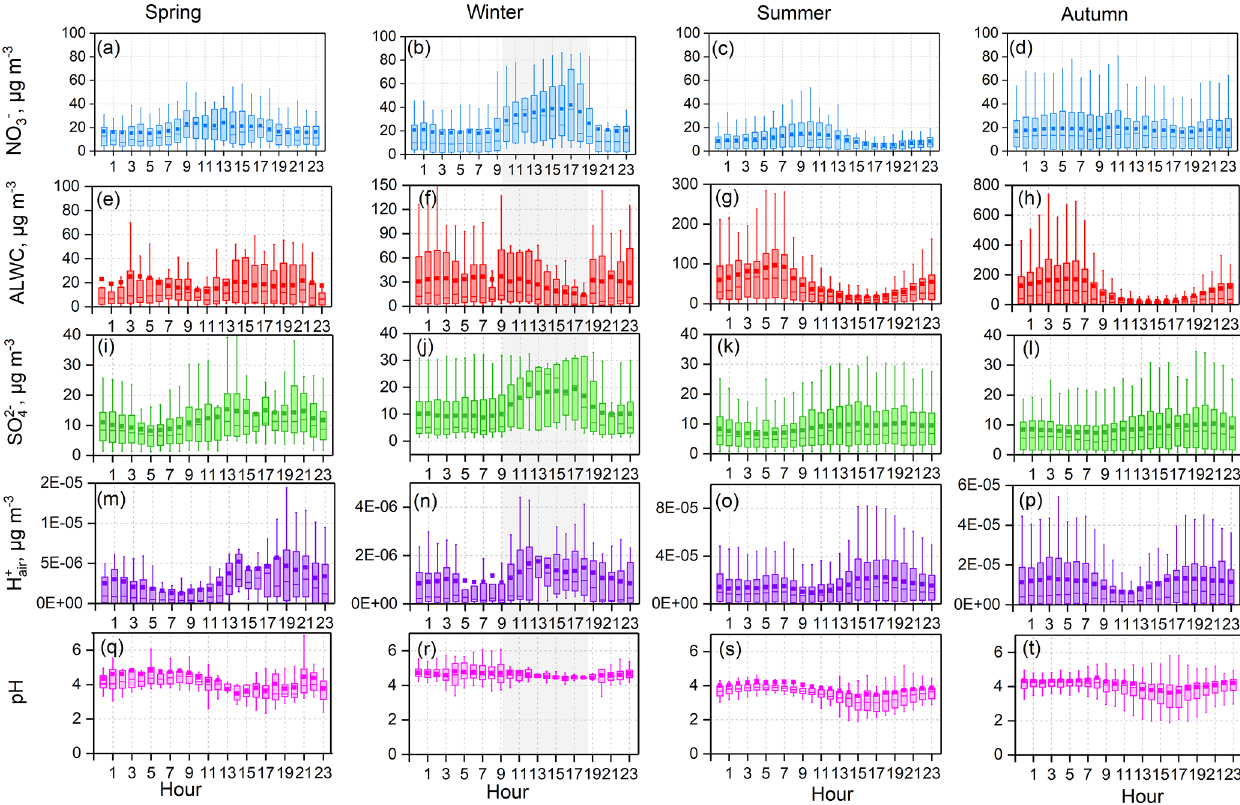
Figure 6. Diurnal patterns of mass concentrations of NO − PM 2 . 5 pH over four seasons. Mean and median values are shown, together with 25% and 75% quantiles. Data at RH ≤ 30% were excluded, and the shaded area represents the time period when most RH values were lower than 30%.